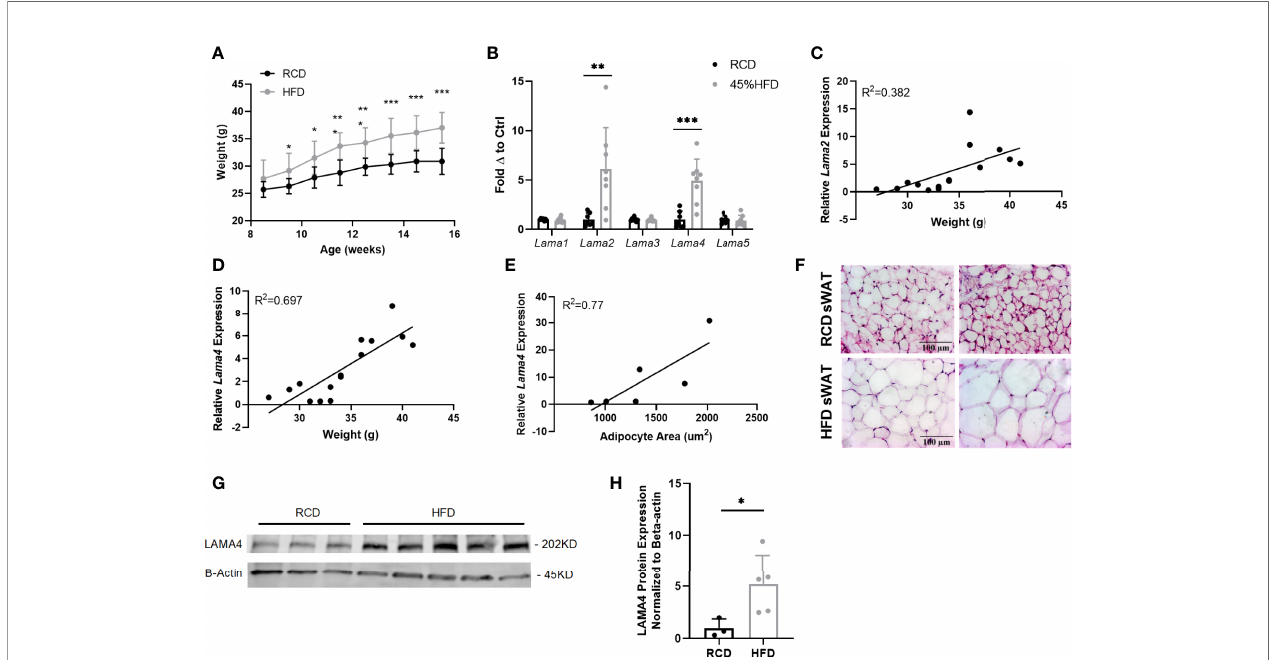
FIGURE 1 | Gene expression of laminin- a chains in sWAT of HFD fed mice. (A) Average weekly weights of mice on regular chow diet (RCD) and 45% High Fat Diet (HFD) for 8 weeks. RCD (n=7), HFD (n=8). (*,**,***) indicates p < 0.05, 0.01, 0.001, respectively. Data are Means ± SD. (B) Laminin- a chain mRNA expression in sWAT of mice after 8 weeks of dietary study normalized to the average of RCD control group. RCD (n=7), HFD (n=8). (C) Relative Lama2 mRNA expression normalized to RCD group graphed against weight (grams) for each mouse in 8-week dietary study (n=15). Simple linear regression analysis. (D) Relative Lama4 mRNA expression graphed against weight (grams) for each mouse in 8-week dietary study (n=15). Simple linear regression analysis. (E) Relative Lama4 mRNA expression graphed against adipocyte area (um 2 ) for one cohort of HFD and RCD mice (n=6). Simple linear regression analysis. (F) Representative images of H&E stained sWAT tissue sections of HFD and RCD mice after 8 weeks of dietary study. All images are 40X magni fi cation. (G) Protein expression of LAMA4 and loading control B-actin in sWAT of mice placed on RCD or 45% HFD for 8 weeks was assessed by western blot. Original blot images can be found in the supplementary fi le. (H) LAMA4 signal from the western blot was quanti fi ed and normalized to the loading control signal. Values are shown as fold changes in comparison to the average of the RCD group. RCD (n=3), HFD